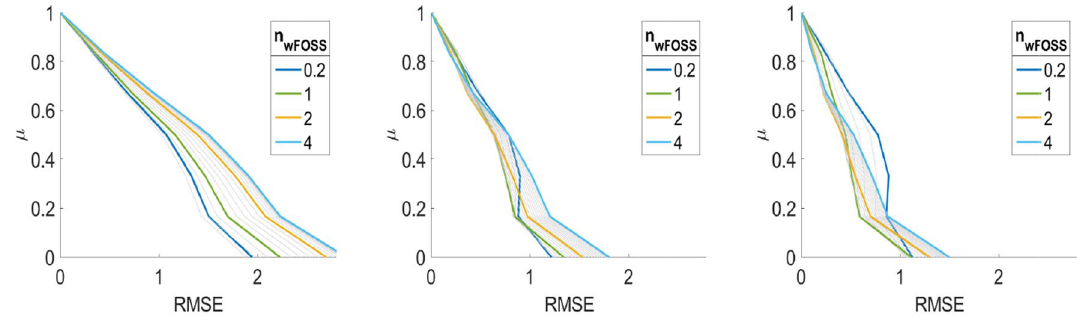
Fig. 12 Camelback function: Average RMSE over the 𝛼 -cuts of the result space for the DACE model with 100 underlying FOSS sampling plans with 4 (left), 9 (center), and 16 (right) sampling points